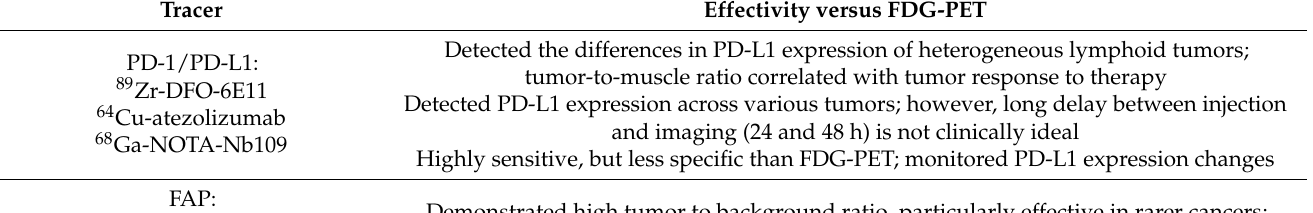
Table 1. Comparison of novel PET radiotracers with FDG-PET in melanoma models [38]. Tracer Effectivity versus